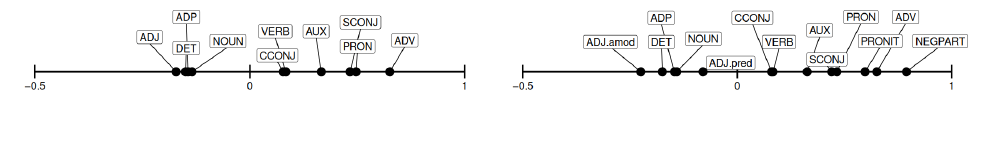
Figure 2. Column scores (variables) for Dimension 1 in a Correspondence Analysis of the POS-tag frequencies in translations and interpretations (left: basic tagset, right: extended